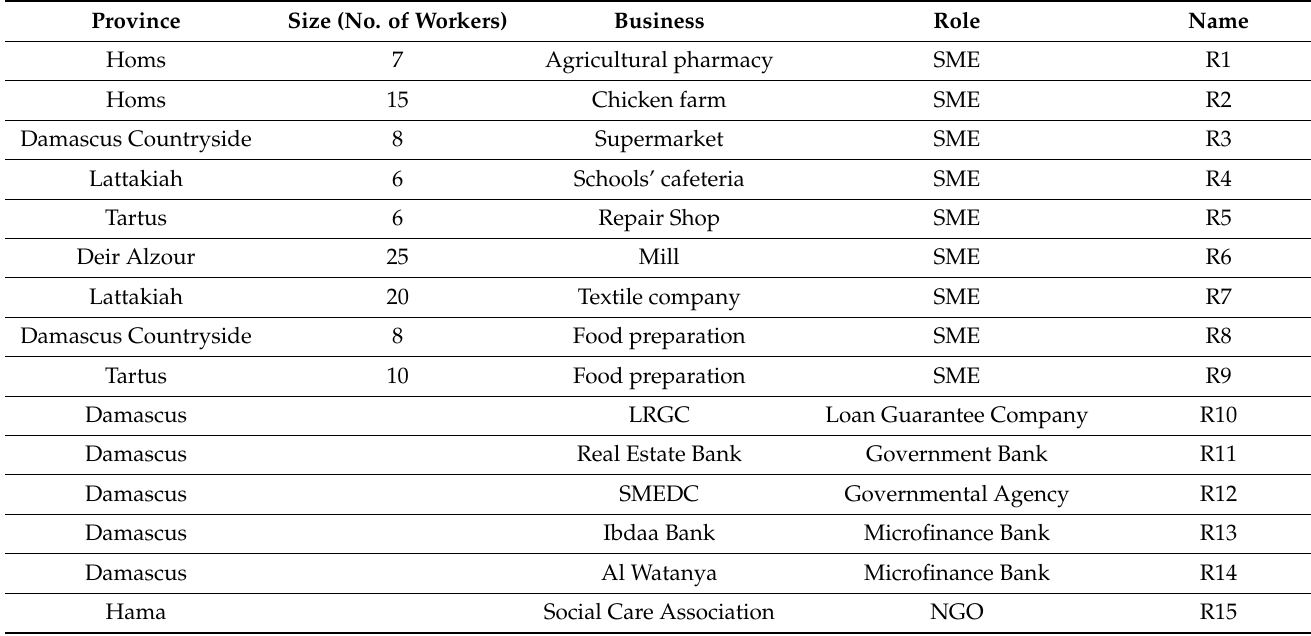
Table A1. Summary of participants’